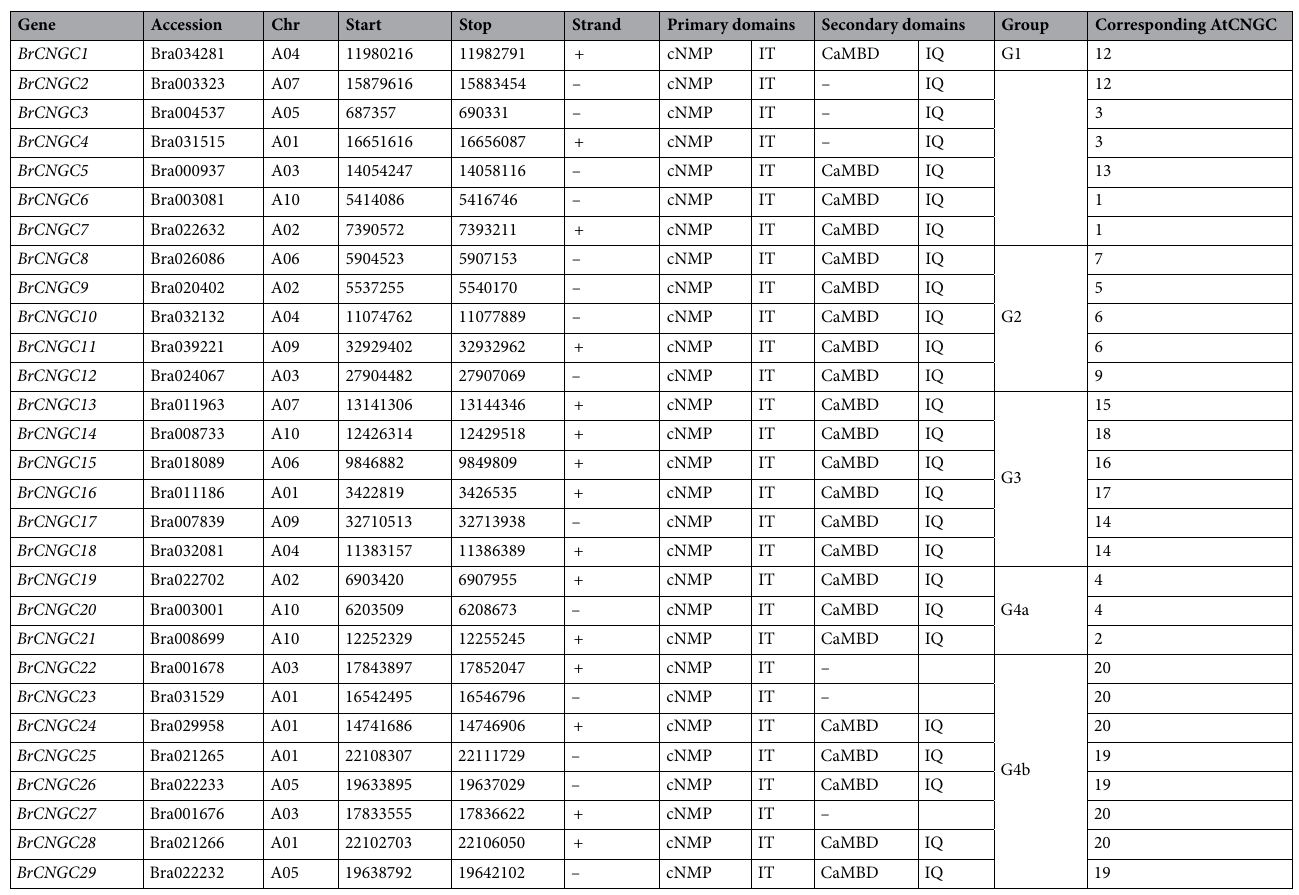
Table 1. Summary of 29 BrCNGC genes identified in the genome of B. rapa